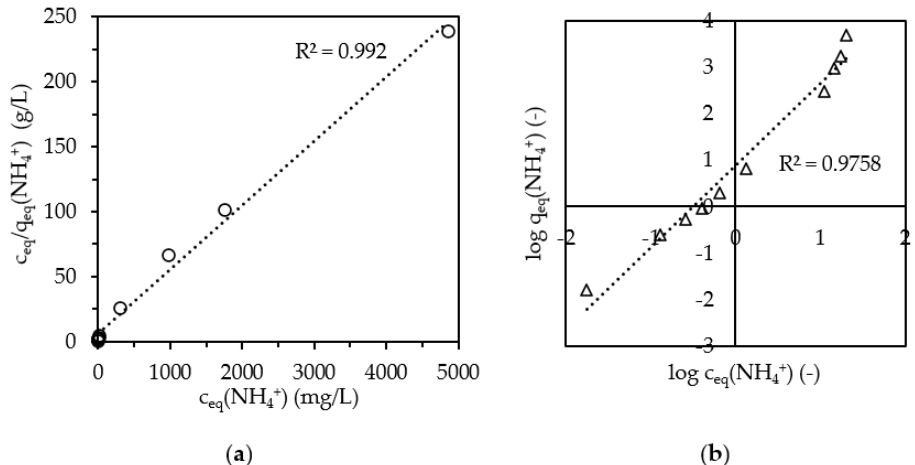
Figure 2. Linear plots of Langmuir ( a ) and Freundlich ( b ) sorption models for NH 4+ sorption on natural zeolite for the full concentration range investigated (matrix: ultrapure water; t eq : up to 90 d; pH 0 : 5.1–5.9; c 0 (NH 4+ ) = 1–5000 mgN/L; w / v = 100 g Z /L; T = 22 °C; grain size: 8–16 mm; n = 3).